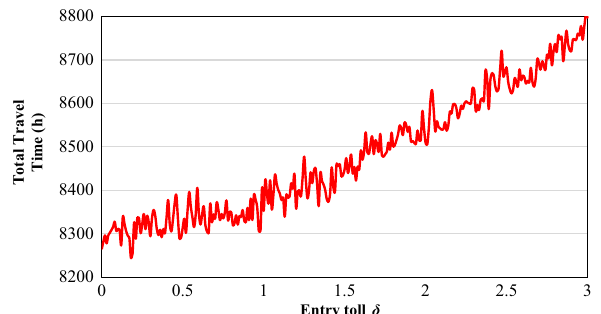
Fig. 7 Variation of total travel time with distance-based toll at entry toll d ¼ 0 : 17 for Sioux Falls